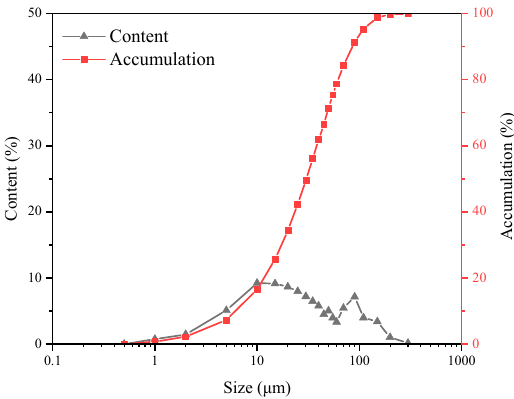
Figure 3. Distribution of the particle size.